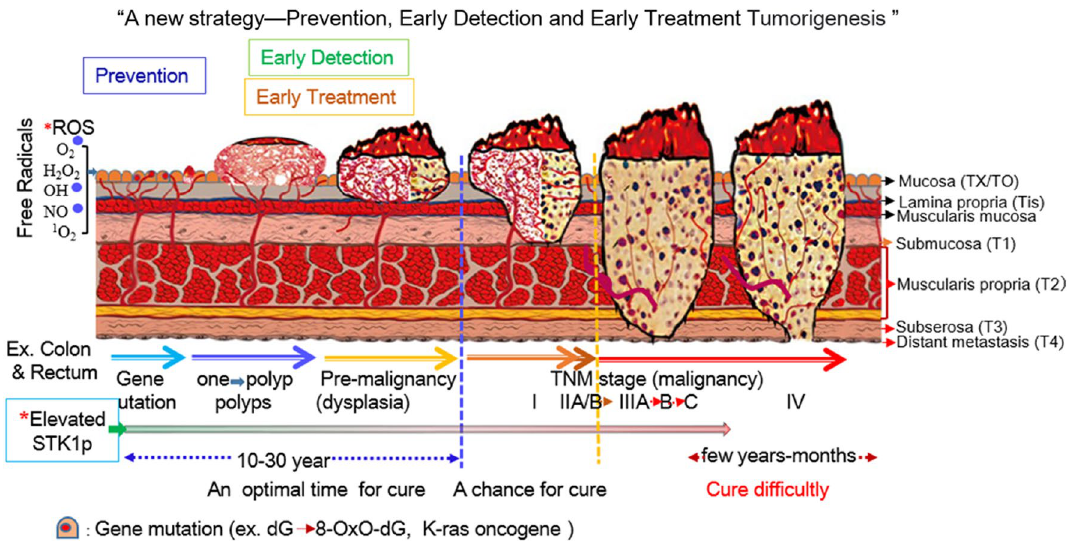
Fig. 5 Schematic diagram of the detection of early colorectal tumorigenesis based on STK1p combined with appropriate imaging. ROS ✸ : Reactive oxygen species from metabolism, inflammation, radiation, pollution, etc.; *Elevated STK1p: the STK1p value significantly increased (P < 0.0001) in the following manner: healthy mucosa (tumor-free) < enlarged polyps < dysplasia < colorectal carcinoma (CRC, TNM stage I-III) [28]. The text is explained in reference no